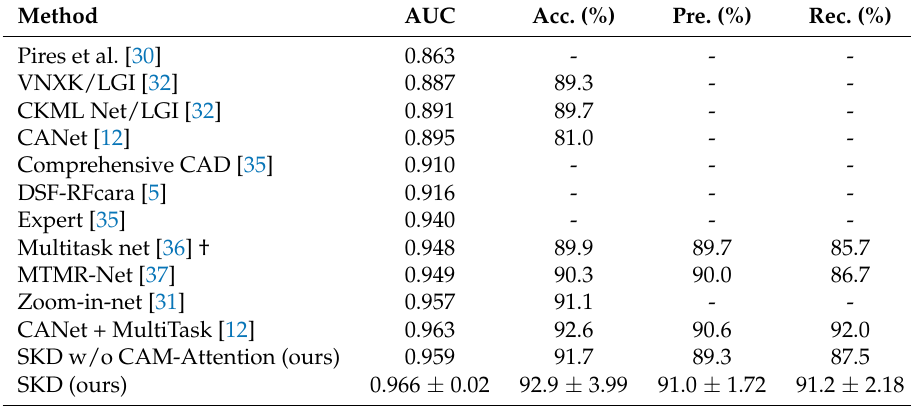
Table 1. Performance comparisons on Messidor dataset. Results are given as the mean or (mean ± std) of 10-fold cross-validation. “†” shows that its results are reproduced from [12] and the remaining values are copied from original